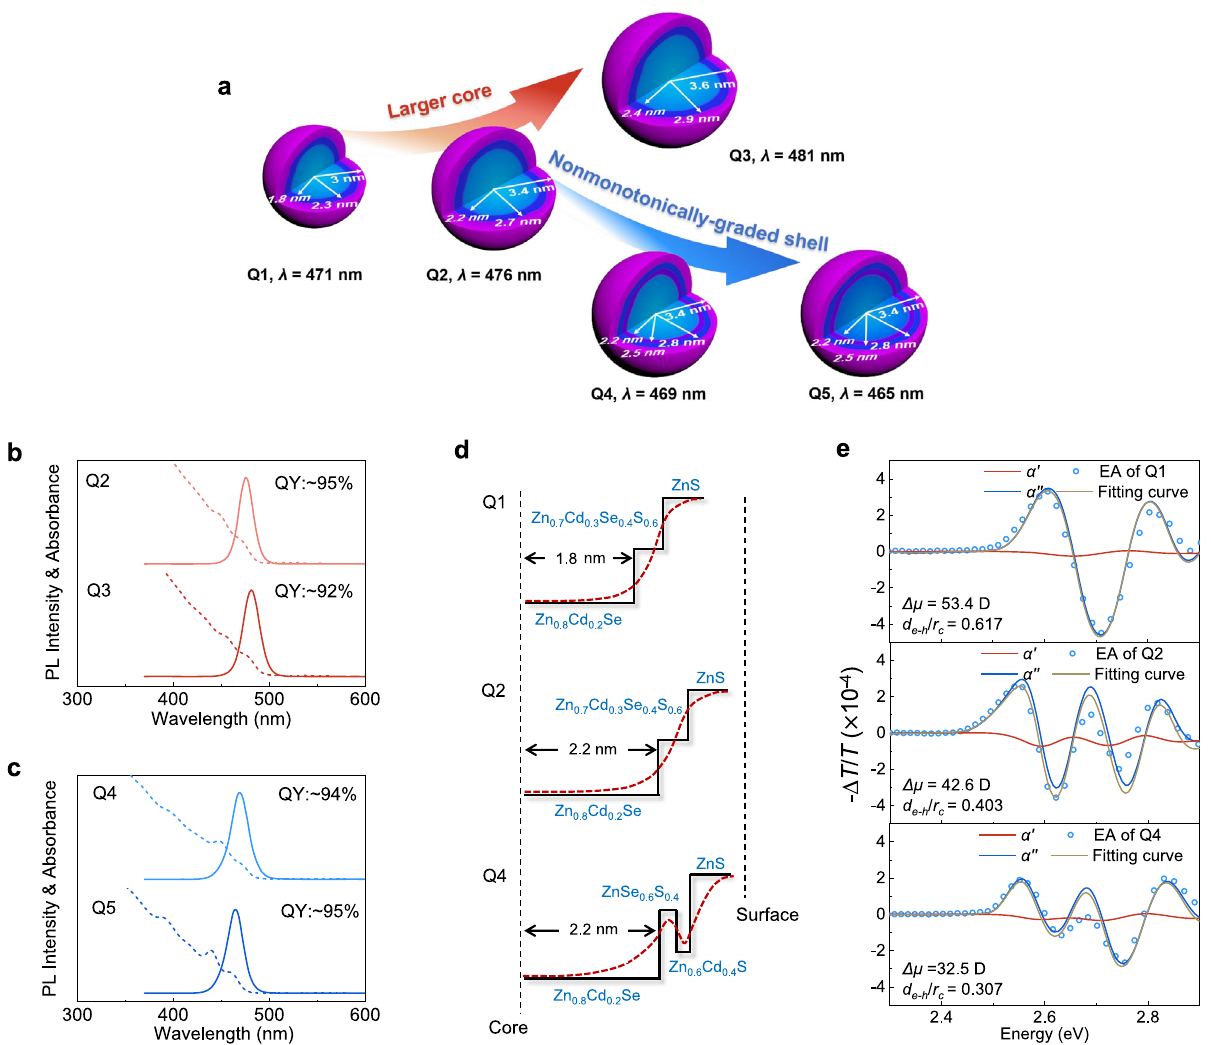
Fig. 2 | Blue quantum dots with reduced surface-bulk coupling. a The core/ shell/shell structures for Q1-Q5. The radial element distribution is obtained using high-resolutionTEMandICP-OES. b , c PLQE,PLspectra,andabsorbancespectraof Q2 – Q5. d Schematicdiagramoftheconductionband minimum of Q1,Q2,